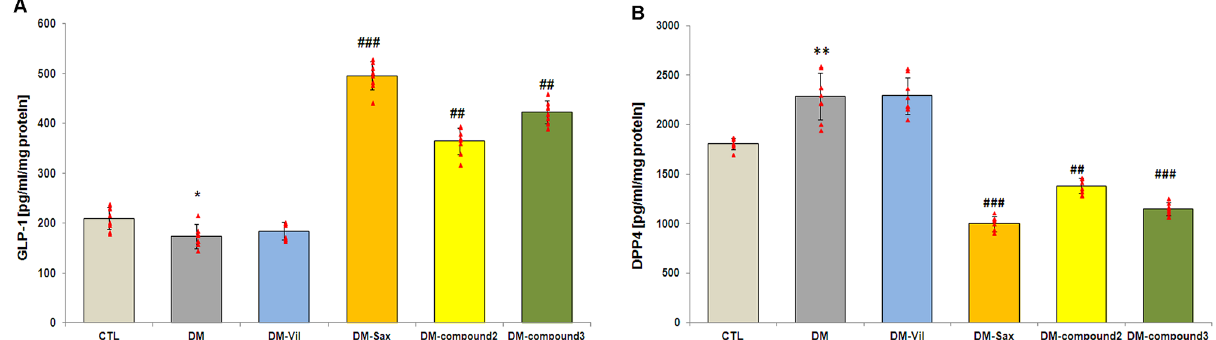
Figure 6. Effect of derivatives ( 2 , 3 ) and vildagliptin, saxagliptin on the protein level of GLP-1 and DPP4 in prefrontal cortex of diabetic mice. GLP-1 ( A ) and DPP4 ( B ) protein levels in prefrontal cortex tissues of mice after 14-days treatment with DPP41s or new adamantane derivatives ( 2 , 3 ). Bars in figure illustrates experimental groups— CTL non-diabetic mice, DM diabetic mice, DM‑Vil vildagliptin-treated mice [20 mg/ kg, po ], DM‑Sax saxagliptin-treated mice [10 mg/kg, po ], DM‑compound 2 compound 2-treated mice [50 mg/ kg, po ], DM‑compound 3 compound 3-treated mice [50 mg/kg, po ], respectively. Data is presented as mean ± SD (n = 8). One-way ANOVA, followed by Tukey’s post hoc test was used. * p < 0.05; **p < 0.01 as compared with healthy control group; ## p < 0.01, ### p < 0.001 compared with diabetic mice prefrontal cortex of diabetic mice compared to the control group (95% CI [2080.7, 2471.1], ** p < 0.01, F = 139.51; Fig. 6B). Mice treated with saxagliptin or new adamantane derivatives 2 and 3 for 14 weeks exhibited a significant increase in GLP-1 protein level in prefrontal cortex compared with diabetic mice (95% CI [471.34, 518.89], ### p < 0.001, F = 277.01; 95% CI [342.87, 386.83], ## p < 0.01, F = 277.01; 95% CI [403.76, 441.79], ## p < 0.01, F = 277.01, Fig. 6A, respectively). The level of GLP-1 protein was further associated with the level of DPP4 release in the examined tissues (Fig. 6A,B). Mice treated with saxagliptin or new adamantane derivatives for 14 days F = 139.51; 95% CI [1316.8, 1448.4], ## p < 0.01; F = 139.51; 95% CI [1095.9, 1202.3], ### p < 0.001, F = 139.51, appro-